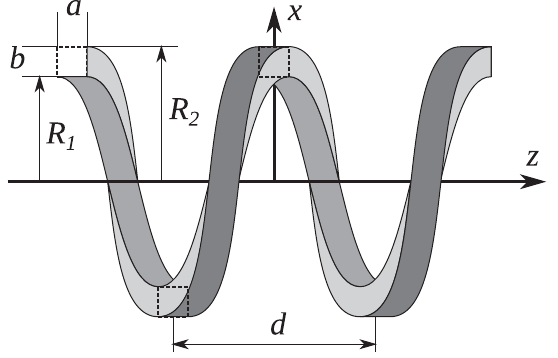
FIG. 1. Ferromagnetic helical insertion into solenoid (two periods are